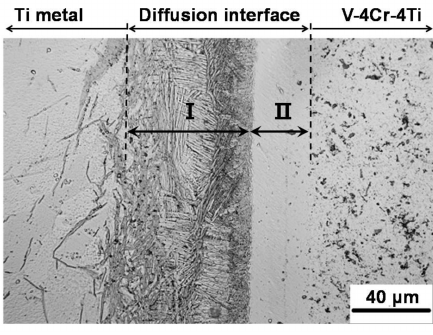
Figure 2. Optical micrograph of a typical V–4Cr–4Ti/Ti bonded